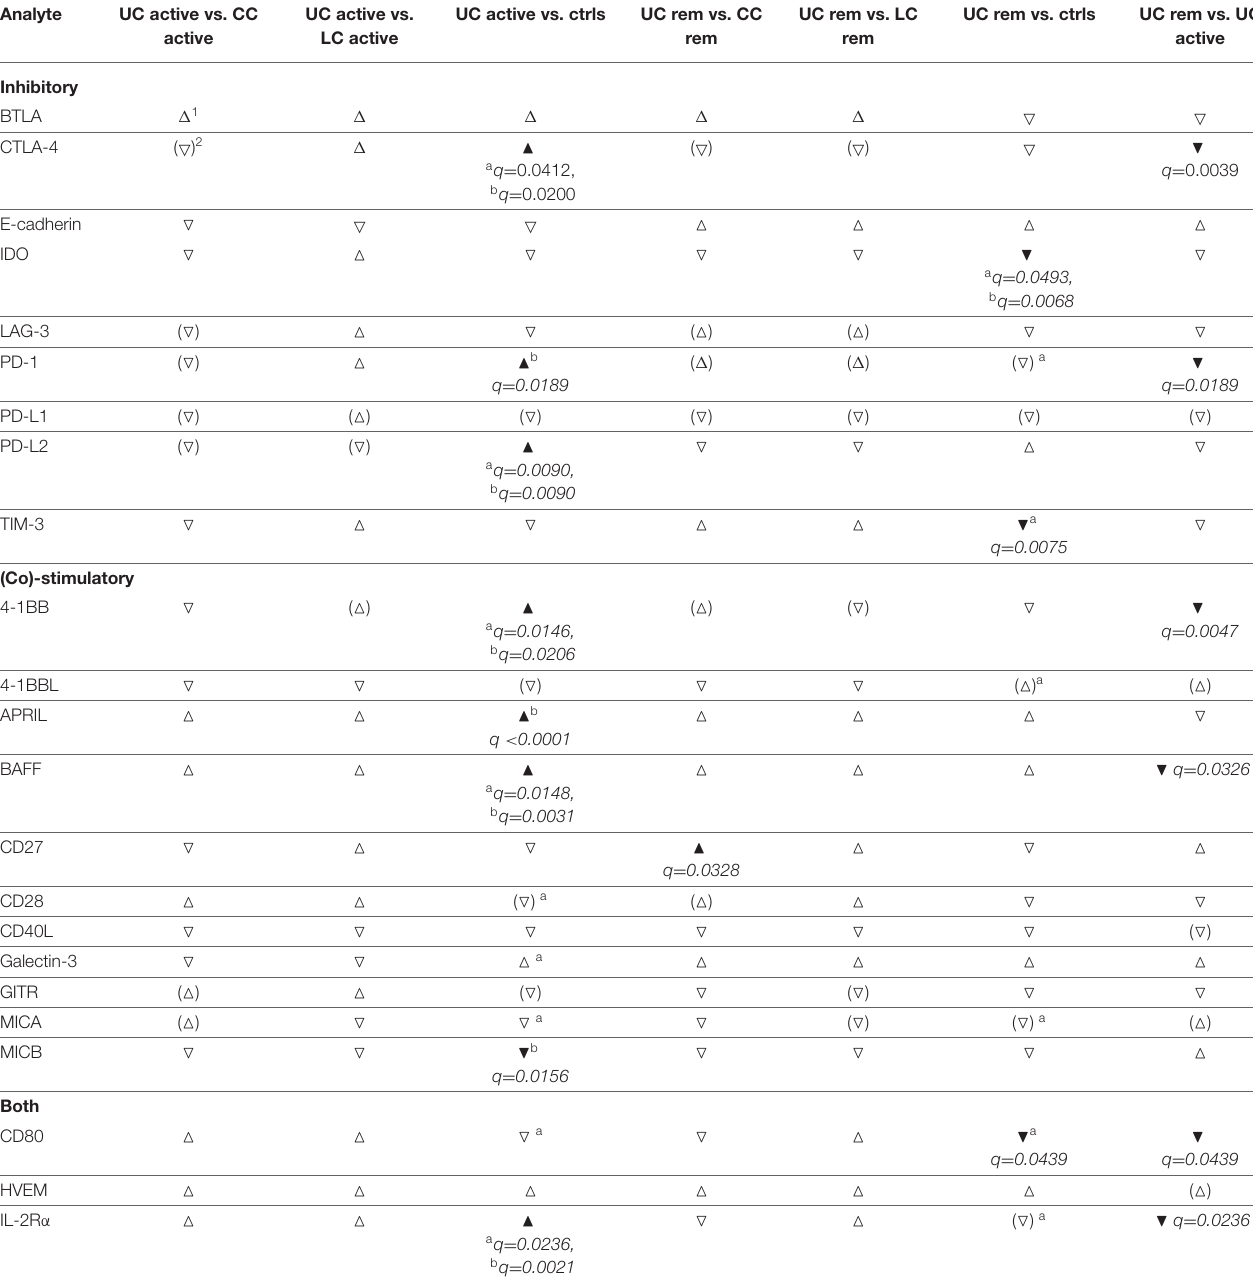
TABLE 6 | Summary of changes in all analytes in biopsies from patients with ulcerative colitis (UC) with active disease and in remission, compared with control groups and patients with lymphocytic colitis in histological remission (LC-HR) as well as patients with collagenous colitis in histological remission (CC-HR). Analyte UC active vs. CC UC active vs. active LC